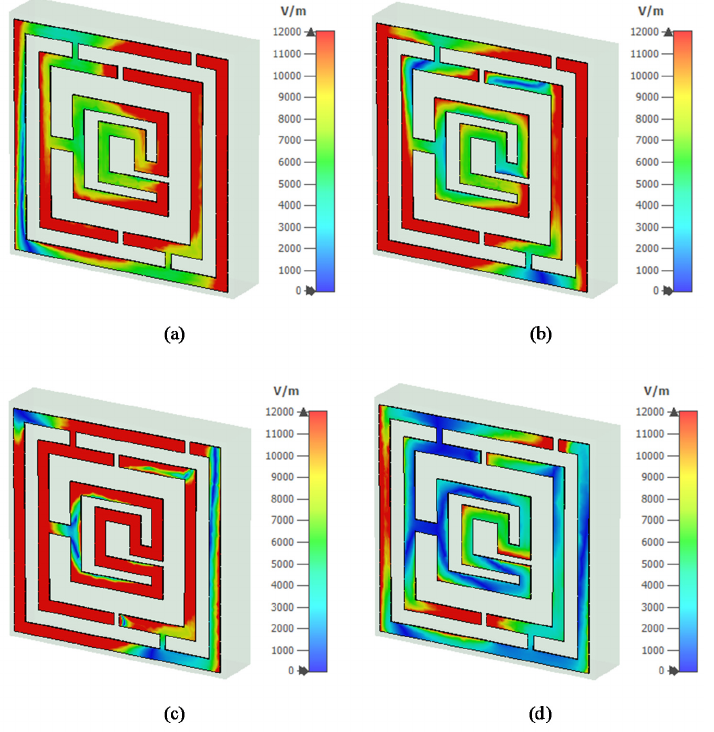
Figure 8. Electric field distribution at ( a ) 2.4 GHz; ( b ) 5.6 GHz; ( c ) 8.9 GHz; ( d ) 11.5 GHz. The electric field (E-field), magnetic field (H-field), and surface current distribution of the proposed metamaterial were analyzed for quad resonance frequency and are shown in Figures 8–10. At the resonance frequency of 2.4 GHz, a strong electric field is seen at the top-right area of the metallic part of the structure, including two outer SRRs; there is an electric field also observed in the inner split of the outer SRRs at the bottom-left area due to the capacitive effect in Figure 8a. At the same time, the magnetic field is observed in the inner double C shape area on the left side of the structure in Figure 9a, where it indicates the opposite reaction from the electric field. Figure 10a shows that a higher sur- face current is observed in those areas where the magnetic field is present.